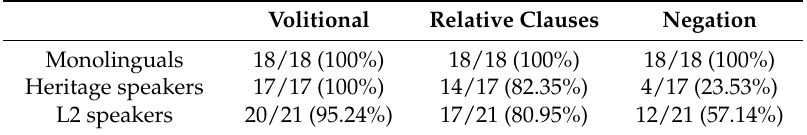
Table 3. Number of participants per group who rated subjunctive higher than